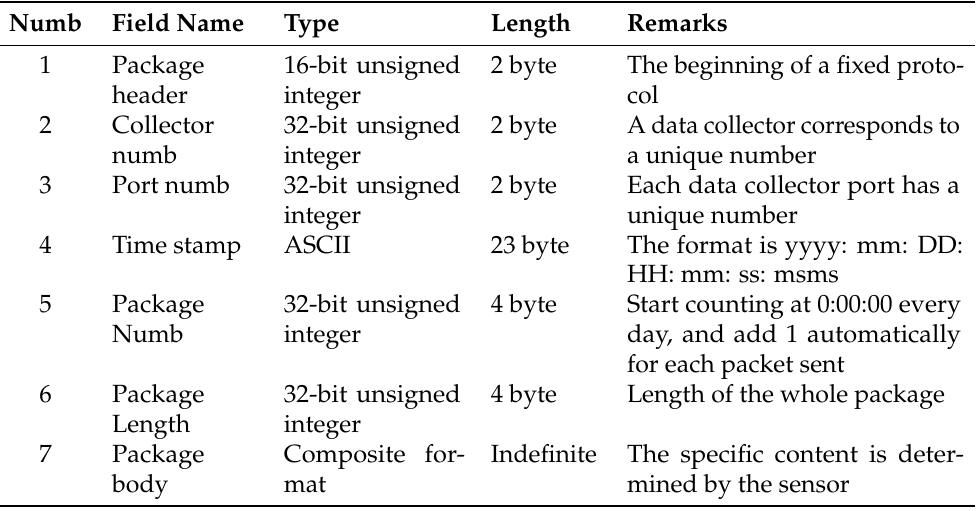
Figure 3. The flow chart of bidirectional socket network communication. Table 1. The format of custom communication